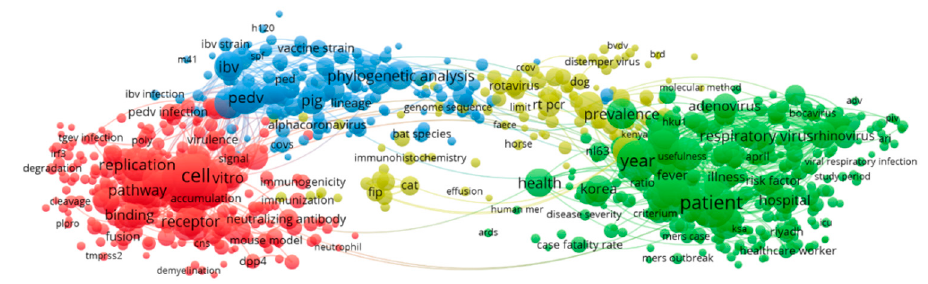
Figure 10. 2016–2019 term co-occurrence Figure 10. 2016 – 2019 term co-occurrence map.